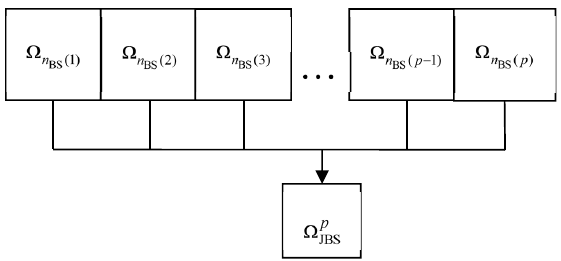
Figure 1. Diagram of simultaneous band selection fusion (BSF).